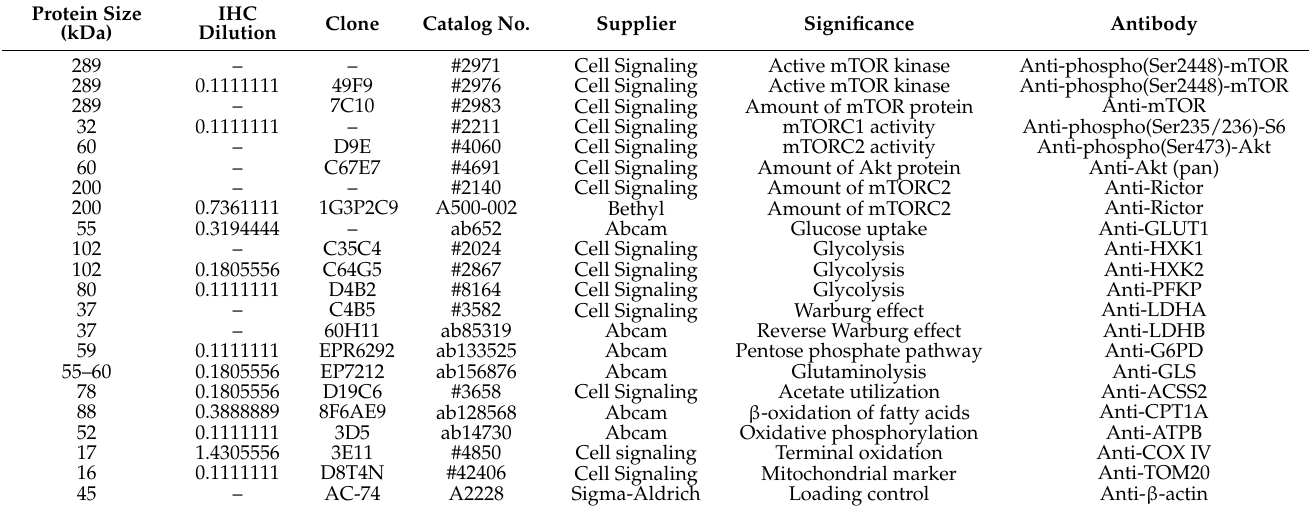
Table 2. Antibodies used for Protein Expression